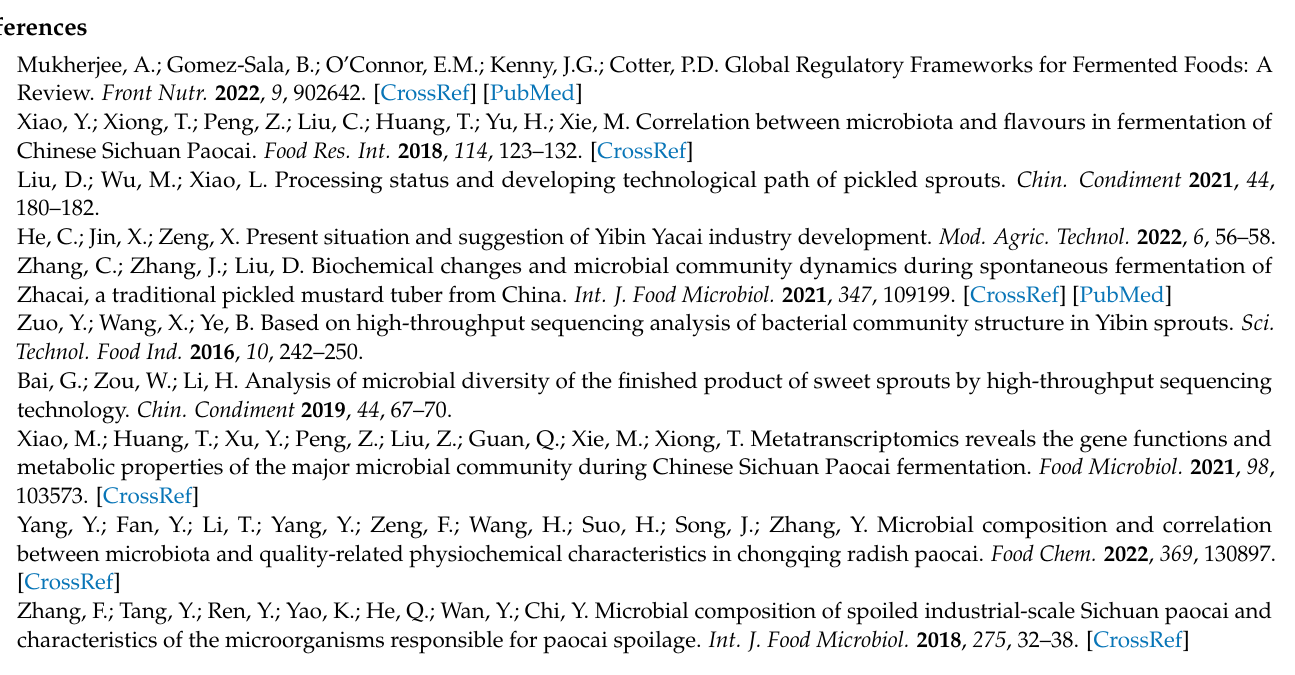
Table S8: Differential metabolites between NF and